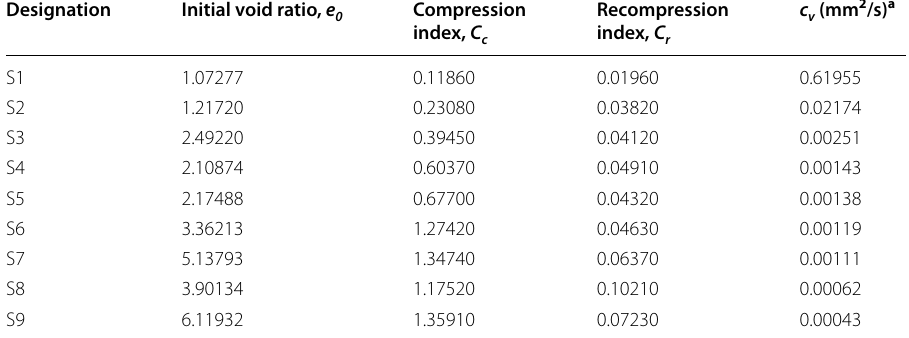
a Coefficient of consolidation at pressure 100 kPa